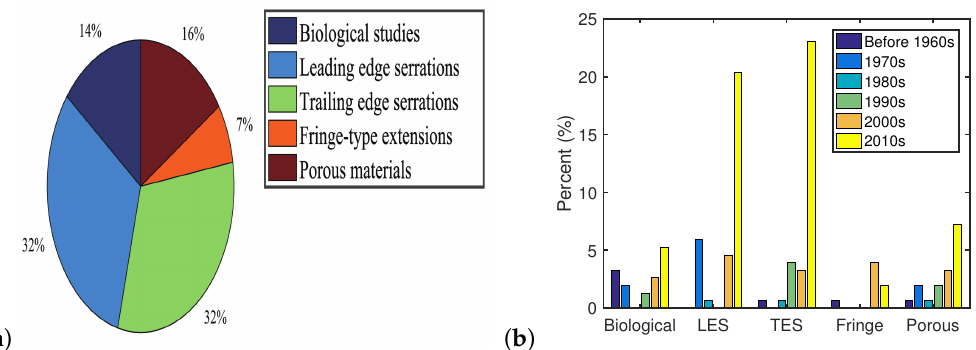
Figure 2. An overview of the studies on bio-inspired aerodynamic noise control: ( a ) by categories; and ( b ) by years (LES and TES denote leading edge serrations and trailing edge serrations,